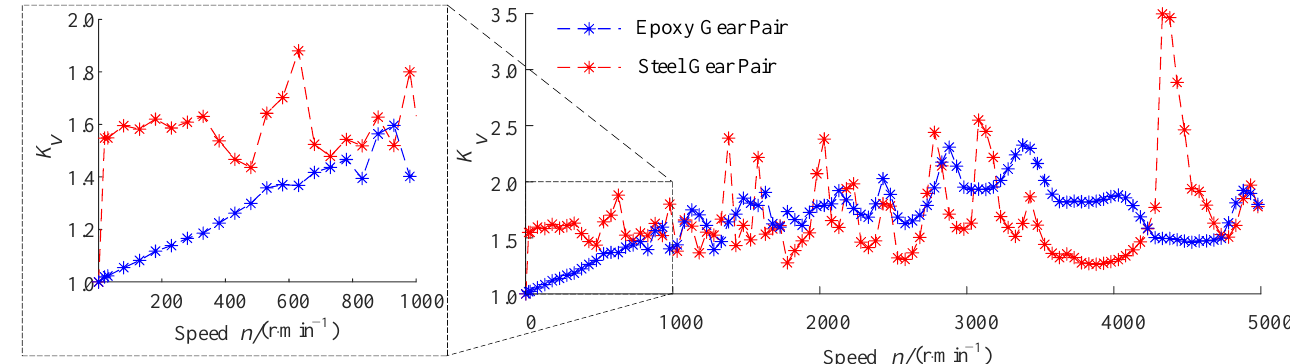
Figure 6. Comparison of 𝐾 𝑣 between epoxy gear pair and steel gear pair. After obtaining the maximum K v , the DMFs of the epoxy and steel gear pairs are taken for further analysis. Figure 7a,b show the simulated DMFs of the epoxy gear pair at 3380 r/min in the time and frequency domains, respectively. In the time domain, the epoxy gear pair is impacted by approach and recess actions, the DMF fluctuates periodically, and tooth separation does not occur. In the frequency domain, the major components of DMF are the mesh frequency (1300 Hz) and its multiple frequencies, and the maximum amplitude occurs at the 6-fold mesh frequency. Figure 7c,d show the simulated DMFs of the steel gear pair at 4330 r/min in the time and frequency domains, respectively. In the time domain, the minimum DMF of the steel gear pair is zero, thereby suggesting that instantaneous tooth separation occurs during gear drive and the drive quality deteriorates. In the frequency domain, the primary components of DMF are mesh frequency (1659.8 Hz) and its multiple frequencies, and the maximum amplitude occurs at the 2-fold mesh frequency. A comparison between Figure 7b,d suggests that the DMF of the steel gear pair shows more sideband components near the mesh frequency and its multiple frequencies, whereas the DMF of the epoxy gear pair shows fewer sideband components.